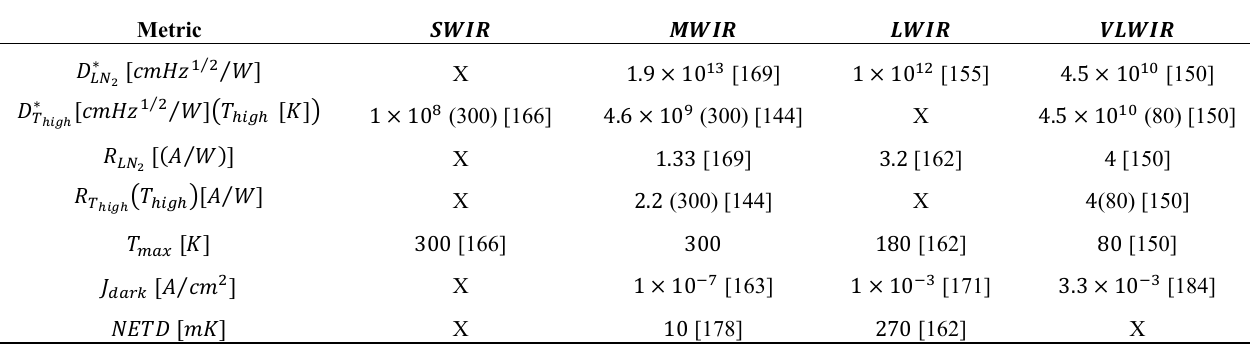
Table 6. Highest reported performance metrics for SLS IRPDs across different wavelength regimes.